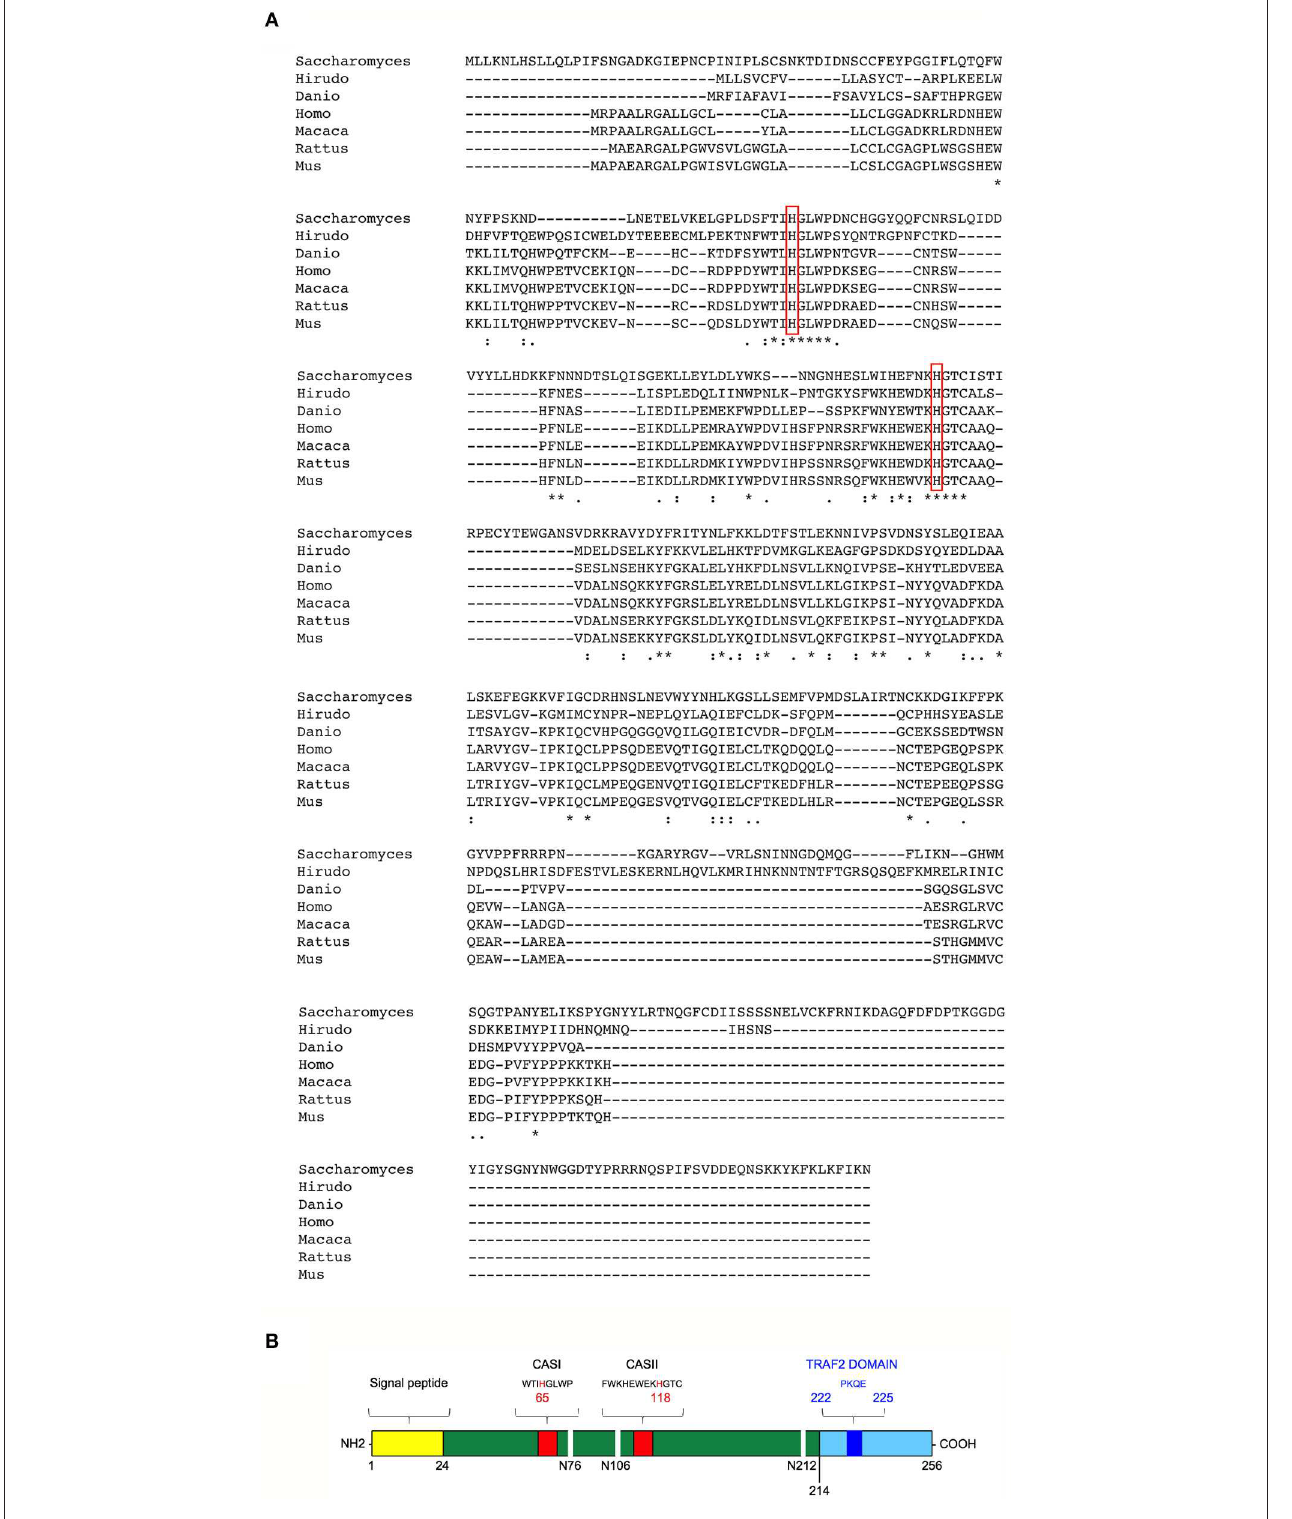
FIGURE 1 | Structural features and evolutionary conservation of T2 RNase proteins. (A) A Clustal Omega alignment of several members of the T2 RNase family, showing the wide evolutionary conservation of this enzymes. RNA cleavage by T2 RNases is mediated by histidine residues (red boxes) embedded into two highly conserved motifs dubbed CAS I and CAS II. The species included in the alignment are Saccharomices cerevisiae, Hirudo verbana, Danio rerio, Homo sapiens,